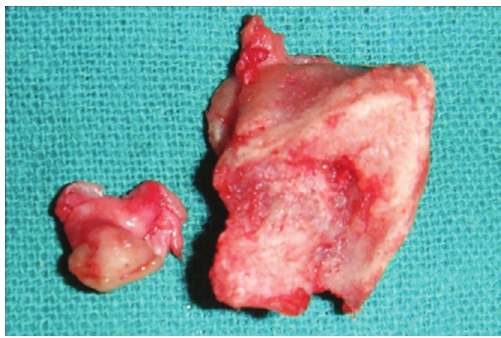
Figure 5: Computed tomography-frontal view.